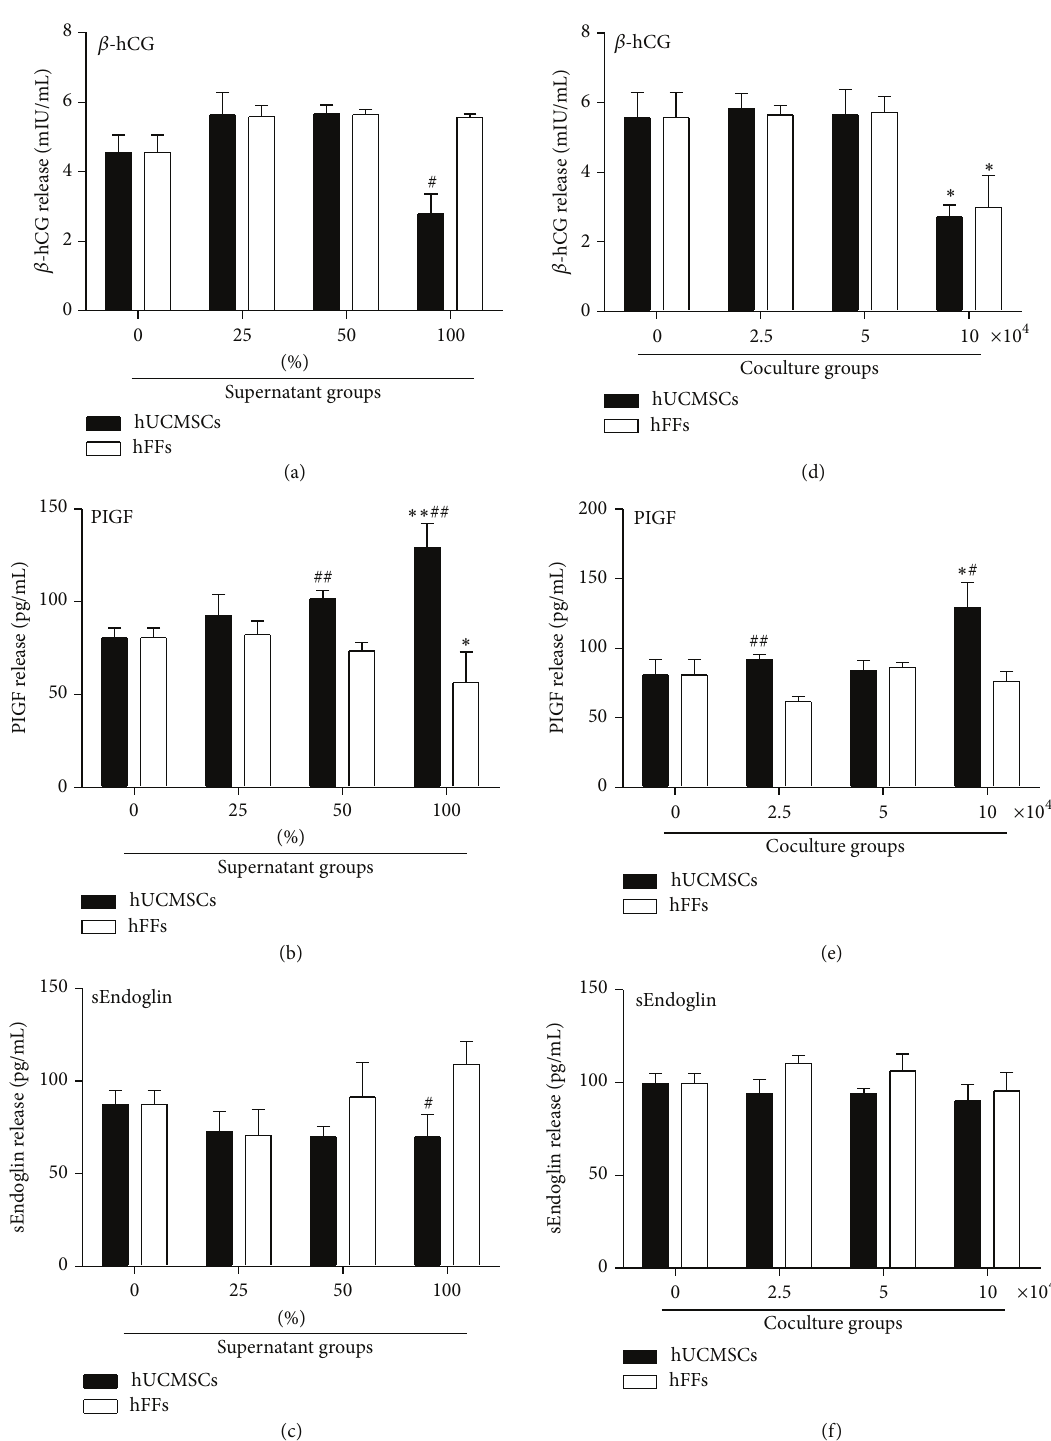
Figure 7: Effect of hUCMSCs and hFFs on cytokine secretion of HTR-8/SVneo cells as detected by ELISA. (a–c) HTR-8/SVneo cells (10 × 10 4 cells/well) were cultured in 0, 25, 50, or 100% hUCMSC or hFF supernatant in medium for 48 hours. (d–f) HTR-8/SVneo cells (10 × 10 4 cells/well) were cocultured with hUCMSCs or hFFs at a concentration of 0, 2.5, 5, or 10 × 10 4 cells/well in 6-well Transwell plates for 48 hours. Cytokine amounts were assessed in the resulting culture medium. ∗ represents significant differences versus control ( 𝑃 < 0.05 ); ∗∗ represents very significant differences versus control ( 𝑃 < 0.01 ); # represents significant differences between hUCMSCs and hFFs at an individual dose ( 𝑃 < 0.05 ); ## represents very significant differences between hUCMSCs and hFFs at an individual dose ( 𝑃 < 0.01